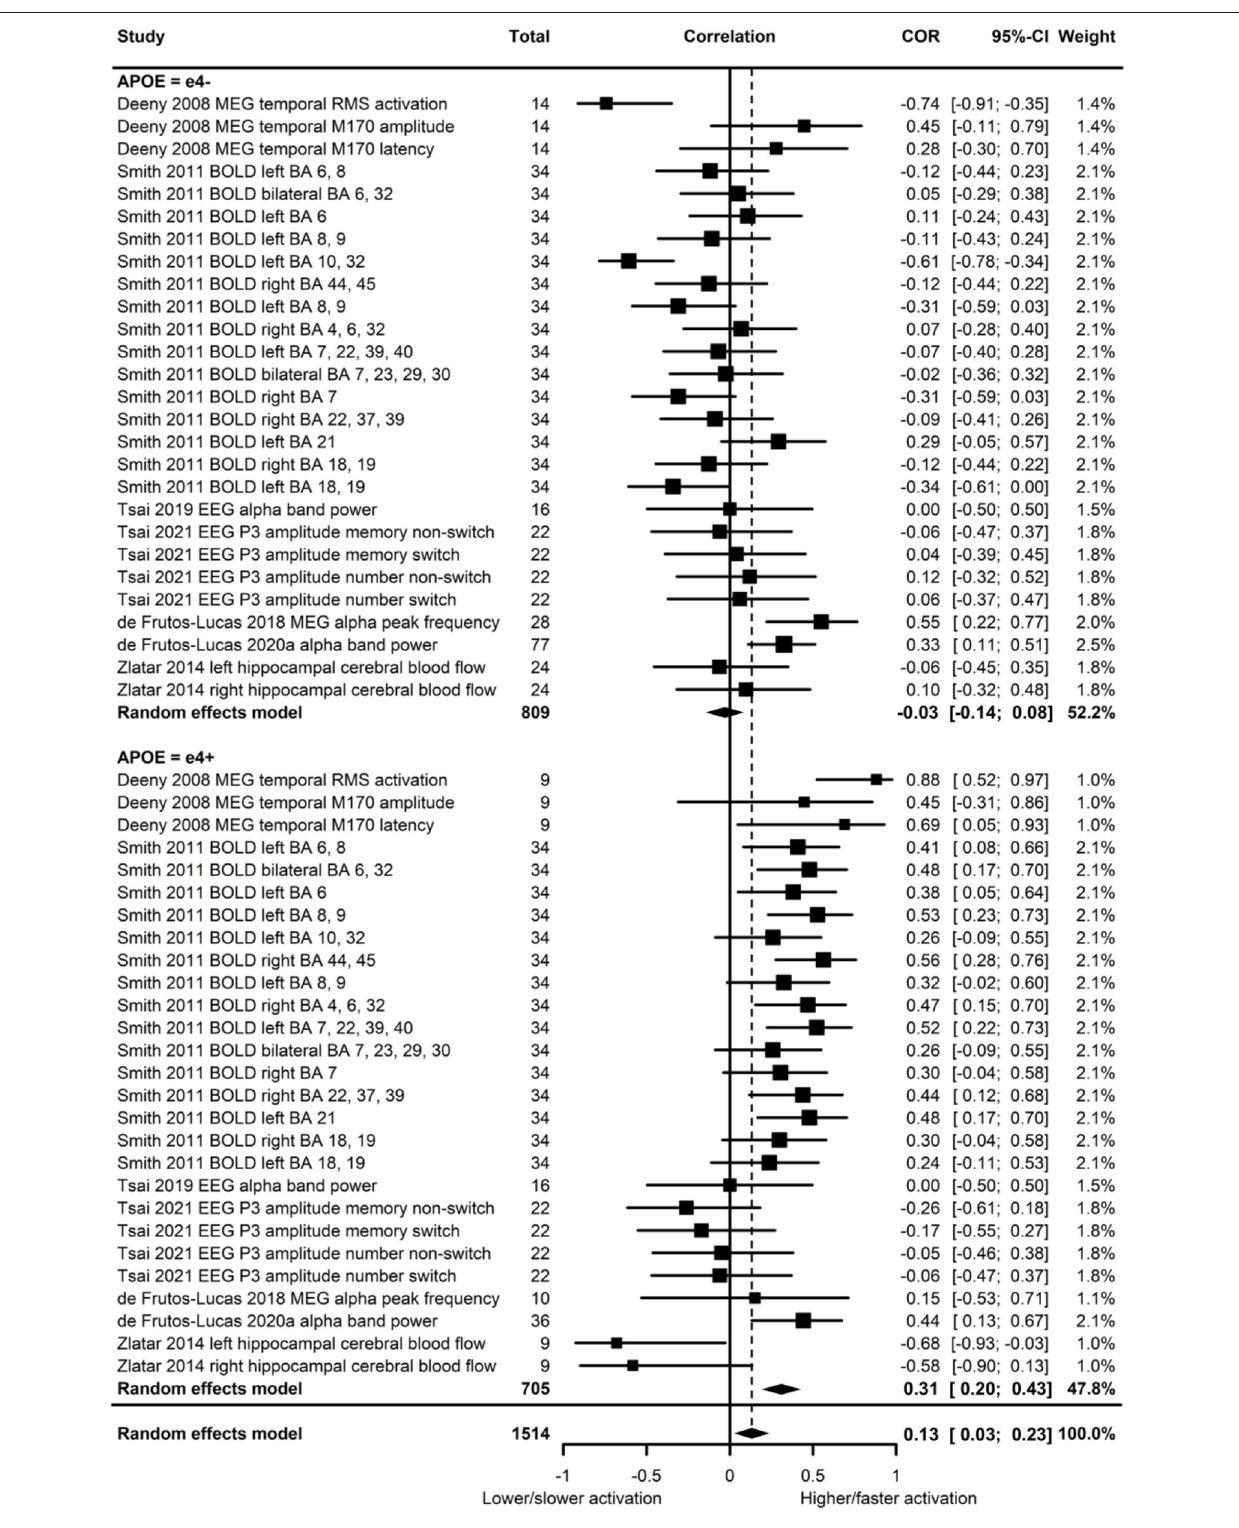
Frontiers in Aging Neuroscience |